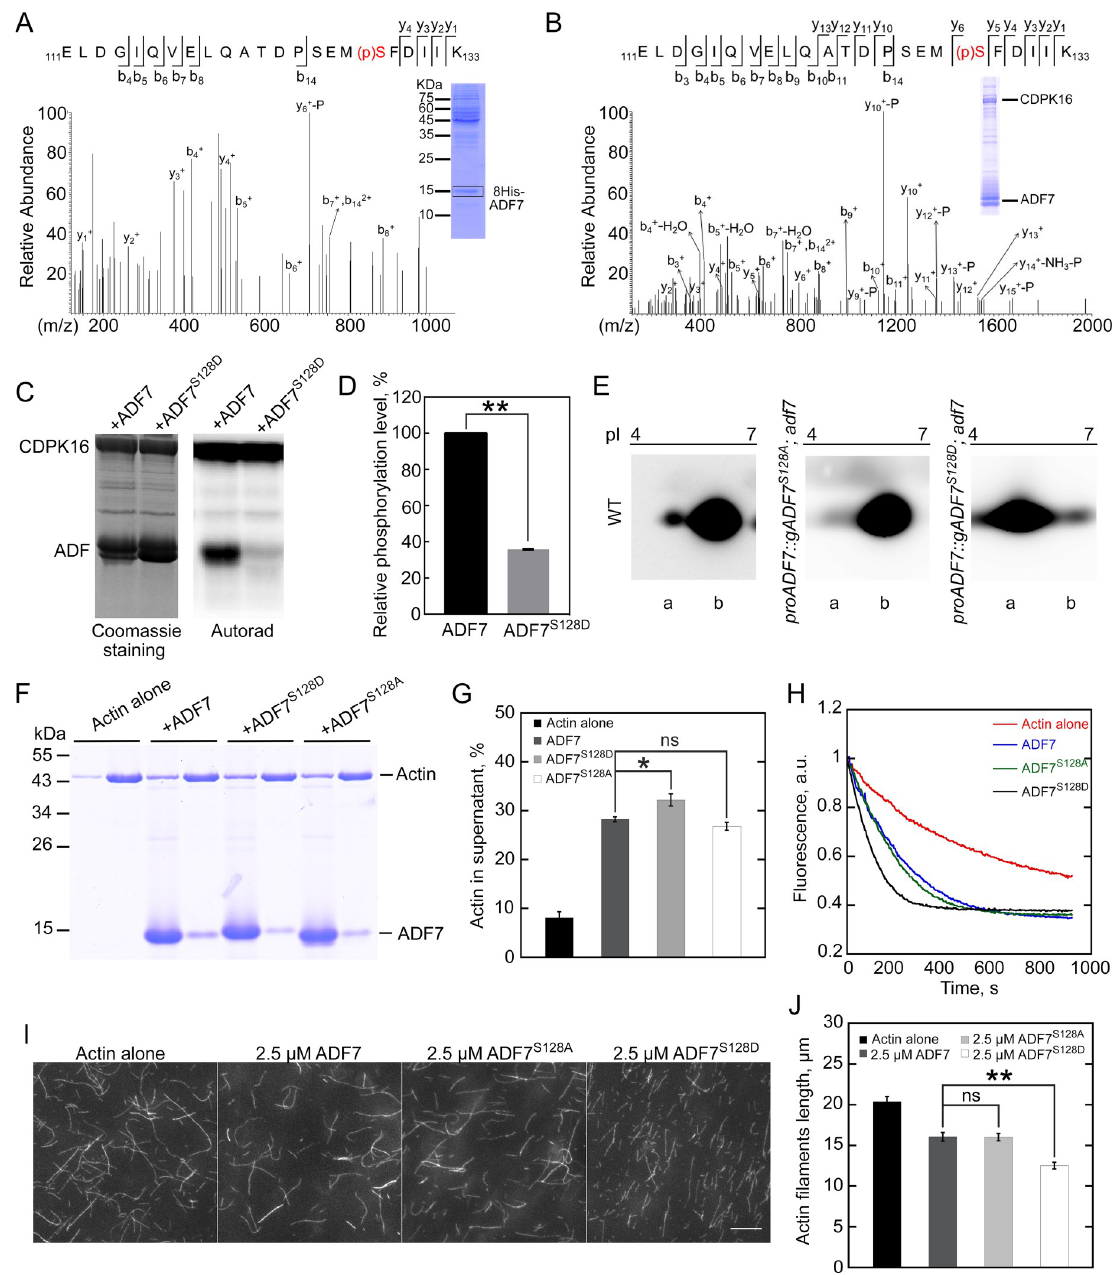
Fig 4. CDPK16 can phosphorylate Ser128 in ADF7, and ADF7 S128D has enhanced actin-depolymerizing and severing activity in vitro . ( A ) Identification of a phosphorylated peptide with the phosphate group conjugated to Ser128. 8His-ADF7 protein was isolated from pollen grains derived from proADF7 :: 8His-gADF7; adf7 and subjected to LC-MS analysis. The original LC-MS data underlying this panel are available in S4 Data. The original pictures are available in S1 Raw Images. ( B ) CDPK16 can phosphorylate Ser128 in ADF7 in vitro . After incubation of 20 μ M ADF7 with 5 μ M CDPK16 in kinase buffer for 30 min, the sample was separated by SDS-PAGE. The ADF7 band was cut out and subjected to mass spectrometry analysis. A phosphorylated ADF peptide with the phosphate group conjugated to Ser128 was identified. The original LC-MS data underlying this panel are available in S4 Data. The original pictures are available in S1 Raw Images. ( C ) CDPK16 fails to phosphorylate ADF7 S128D -6 × His. Purified ADF7-6 × His and ADF7 S128D -6 × His were incubated with CDPK16 in a kinase reaction buffer and the phosphorylation signals were detected by [ γ - 32 P] ATP autoradiography. The original pictures are available in S1 Raw Images. ( D ) Quantification of the relative phosphorylation level of ADF7 shown in ( C ). The data are presented as mean ± SE, n = 3, ** P < 0.01 (Student’s t test). Numerical data underlying this panel are available in S4 Data. ( E ) 2D electrophoresis assay. Total proteins from mature pollen of WT, proADF7 :: gADF7 S128A ; adf7 and proADF7 :: gADF7 S128D ; adf7 were subjected to